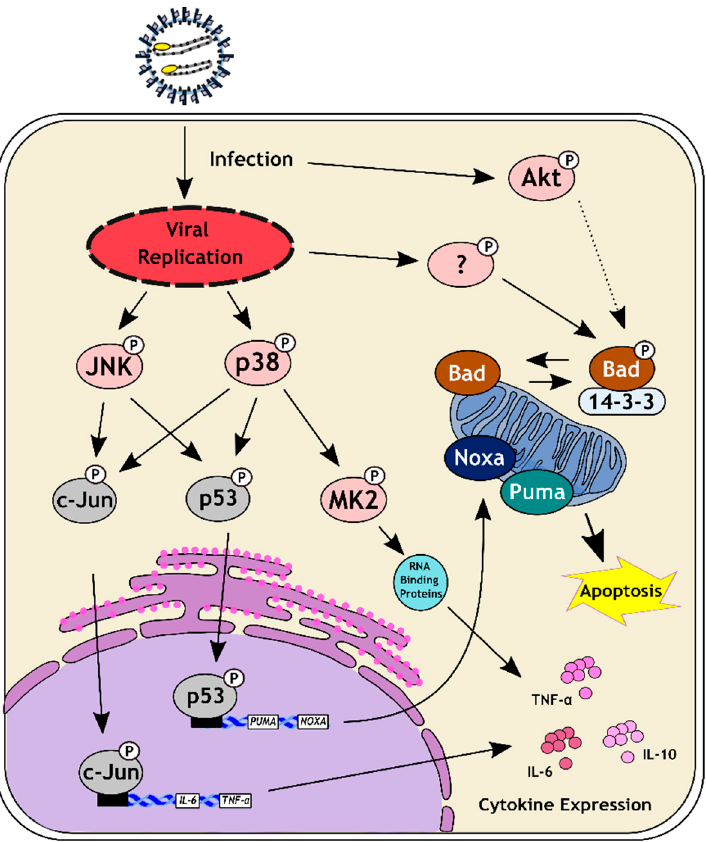
Figure 5. Model for the role of kinase signaling in the regulation of apoptosis induction and the cytokine response to TCRV infection. TCRV triggers transient phosphorylation/activation of the pro-survival kinase Akt very early after infection. While in other contexts this kinase is known to trigger phosphorylation of the pro-apoptotic factor Bad (leading to its inactivation through sequestration by the 14-3-3 protein), the timing of its activation does not coincide with other apoptosis-related signaling events. This suggests that the phosphorylation of Bad observed during TCRV infection [17] must be mediated by another yet unknown kinase. Once productive infection has been established, TCRV infection also results in phosphorylation/activation of the stress-activated protein kinases p38 and JNK. This coincides with other pro-apoptotic signaling events (i.e., p53 phosphorylation, expression of Puma and Noxa) [17], suggesting a potential role for these pro-apoptotic kinases in activating TCRV-mediated apoptosis. Downstream targets of p38 and JNK, which include the kinase MK2 and the transcription factor c-Jun, are also activated late during infection. These factors are also known to regulate apoptotic processes. However, they are associated with cytokine expression as well, either directly by acting as a transcription factor (i.e., c-Jun), or indirectly by activating RNA-binding proteins that stabilize cytokine mRNA transcripts, and particularly those shown to be upregulated during TCRV infection of primary target cells (i.e., TNF- α , IL-6, IL-10) [11]. We were able to detect strong phosphorylation for both p38 and JNK (Figure 2) late in TCRV infection. This is consistent with the timeframe during which accumulation and phosphorylation of p53 occur, as well as classical hallmarks of apoptosis, such as visible morphological changes (i.e., cell death), loss of membrane asymmetry and caspase activa- tion [15,17]. Importantly, both of these kinases are known to phosphorylate p53, thereby inducing its stabilization and activation [19,20,28]. Interestingly, although the highly path- ogenic JUNV does not induce caspase activation or apoptotic cell death, due to its ability to use its nucleoprotein (NP) as a decoy substrate for caspase cleavage [18], we have pre- viously shown that similar upstream pro-apoptotic signaling events (i.e., stabilization and phosphorylation of p53) are also occurring [17]. Consistent with this, we also saw phos- phorylation of both p38 and JNK during JUNV infection (Supplementary Figure S1). Sur- prisingly, recent data have indicated that the JUNV vaccine strain Candid#1 also induces